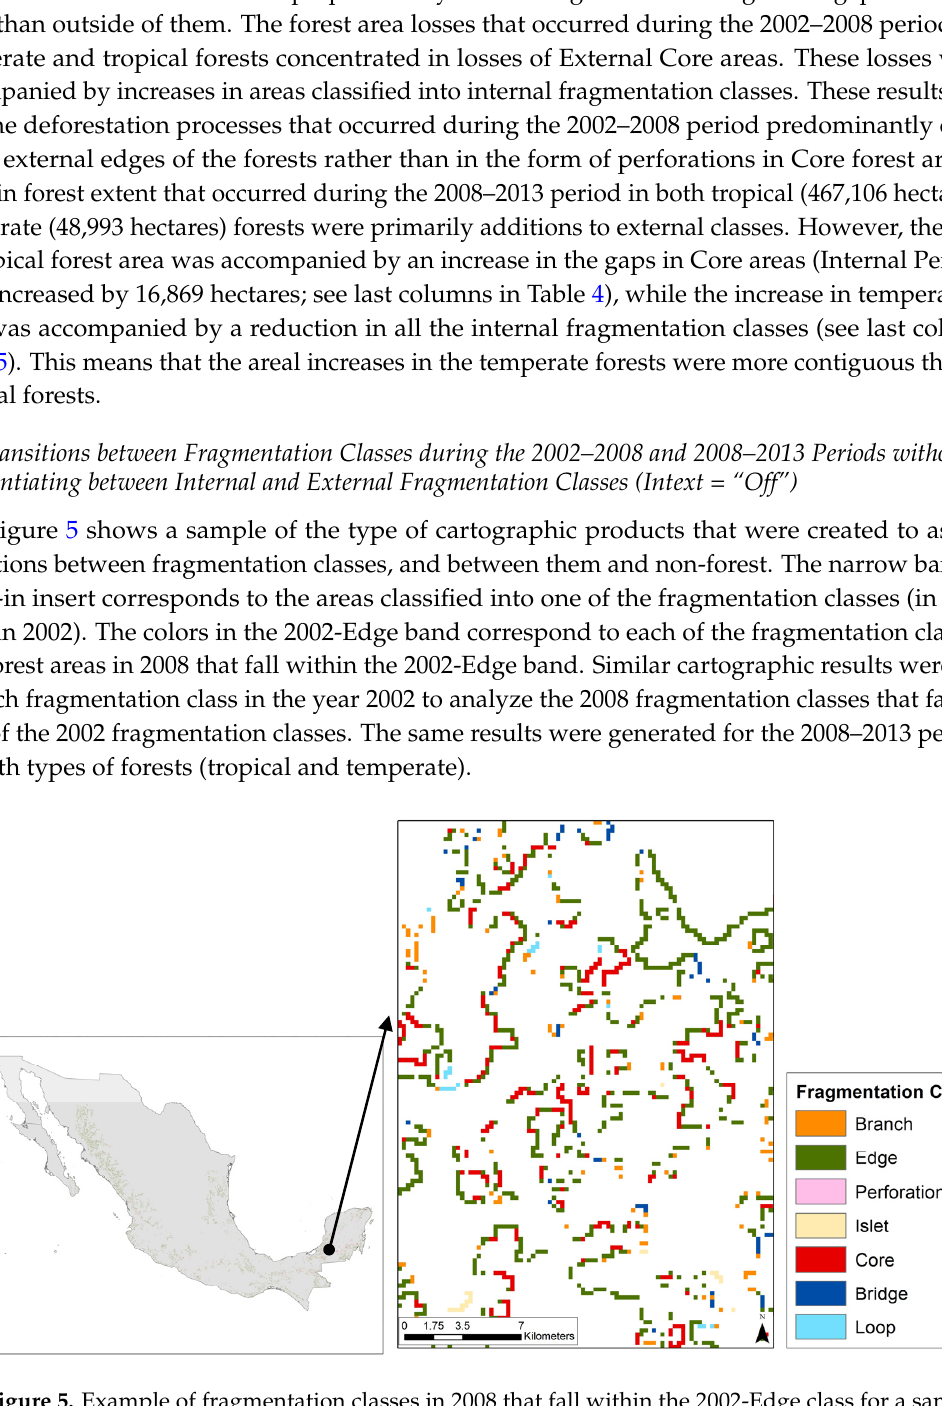
Figure 5. Example of fragmentation classes in 2008 that fall within the 2002-Edge class for a sample area of tropical forests.